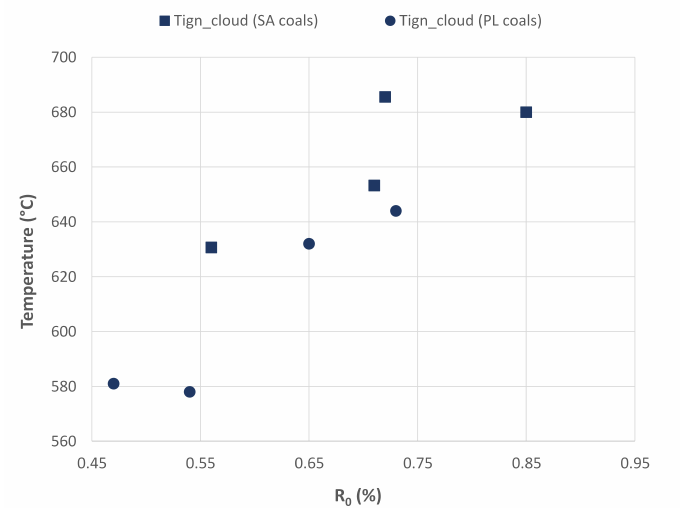
Figure 4. Effect of vitrinite reflectance ( R 0 ) on the dust ignition temperature, T cloud